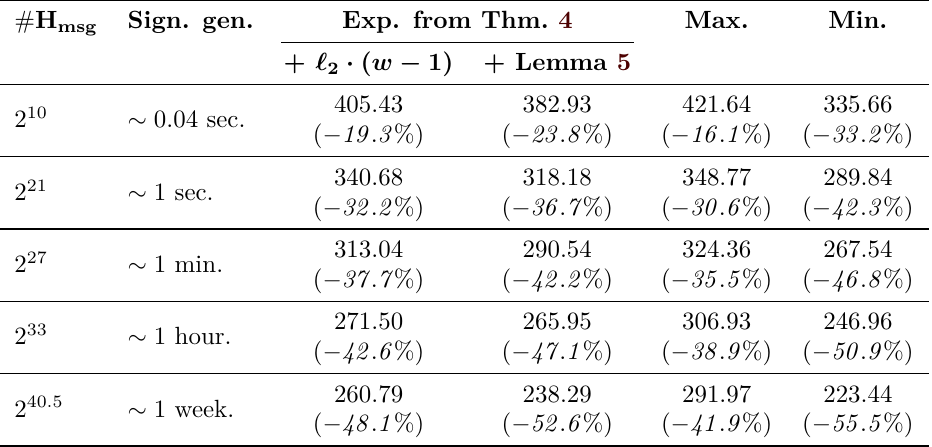
Table 7.2: Trade-off between signature generation and verification time for message hashing, expressed in the number of calls to hash chaining function F as a function of the number of different counter values in H msg : improvement compared to standard XMSS are displayed in